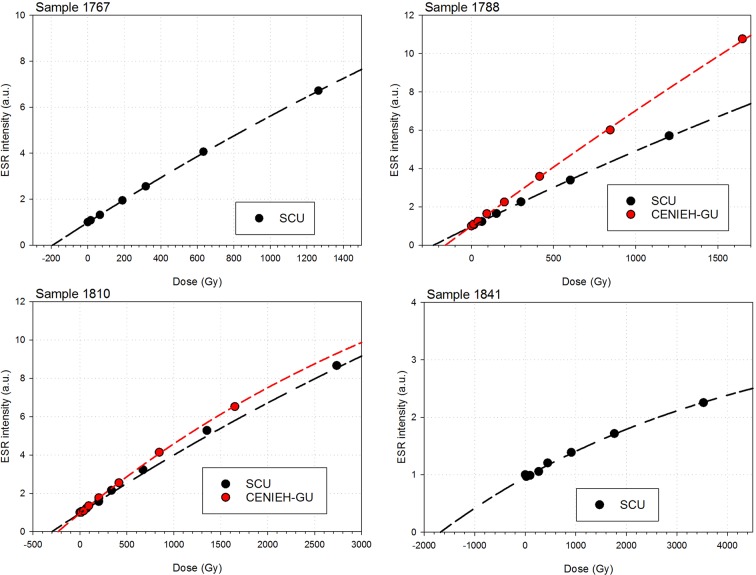
ESR dose response curves (DRC’s) obtained for the samples 1767, 1788, 1810 and 1841.To facilitate comparison, all DRC’s have been normalised to the intensity of the natural point (=1).